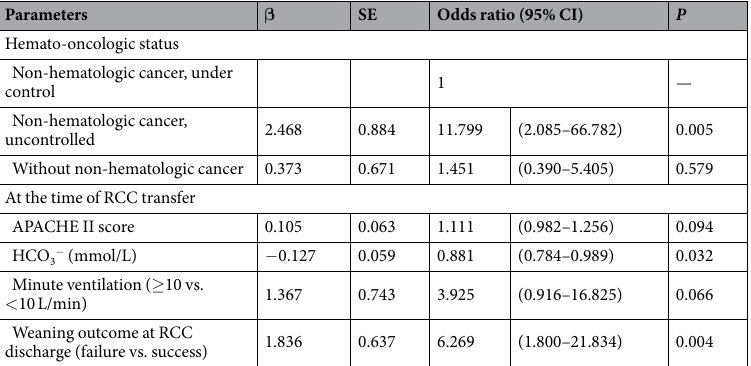
Table 4. Multivariate logistic regression models for significant clinical characteristics associated with 1-year mortality * . APACHE II, Acute Physiology and Chronic Health Evaluation score; CI, confidence interval; RCC, respiratory care center; SE, standard error. * Variables with statistical significance ( P < 0.05) in the univariate analyses (Tables 1, 2, and 3) were included in the multivariate logistic regression models. Backward variable selection was performed, and the criteria of P values for entry and stay were set at 0.05 and 0.10,